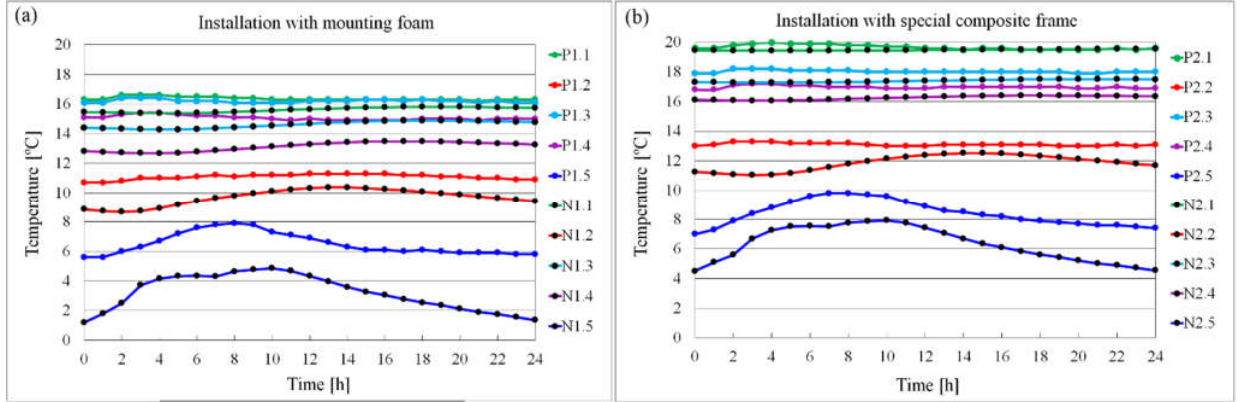
Figure 5. Temperature vs. time for bottom sections of windows installed in external wall: ( a ) in conventional way, ( b ) using composite frame. Points P1.1 ÷ P2.5—experimental results, nodes N1.1 ÷ N.2.5—numerical results.